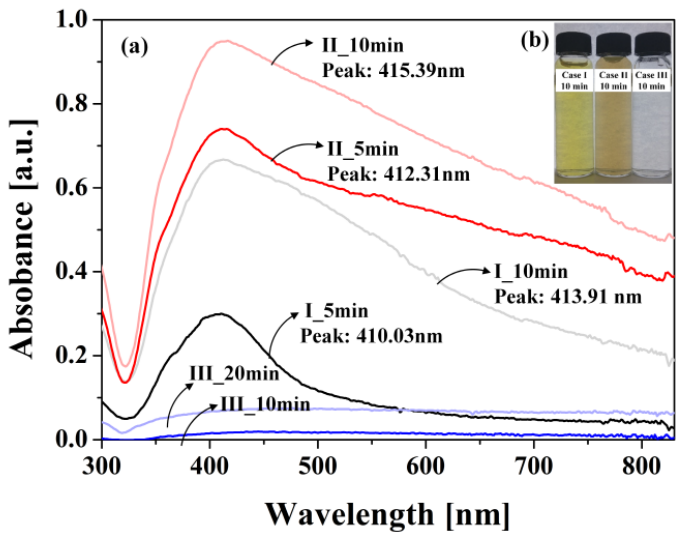
Figure 8. UV-Vis absorption spectra for six different Ag NP suspensions prepared by LPP: ( a ) UV-Vis absorption spectra and (( b ) inset) corresponding colors of Ag NP suspensions.